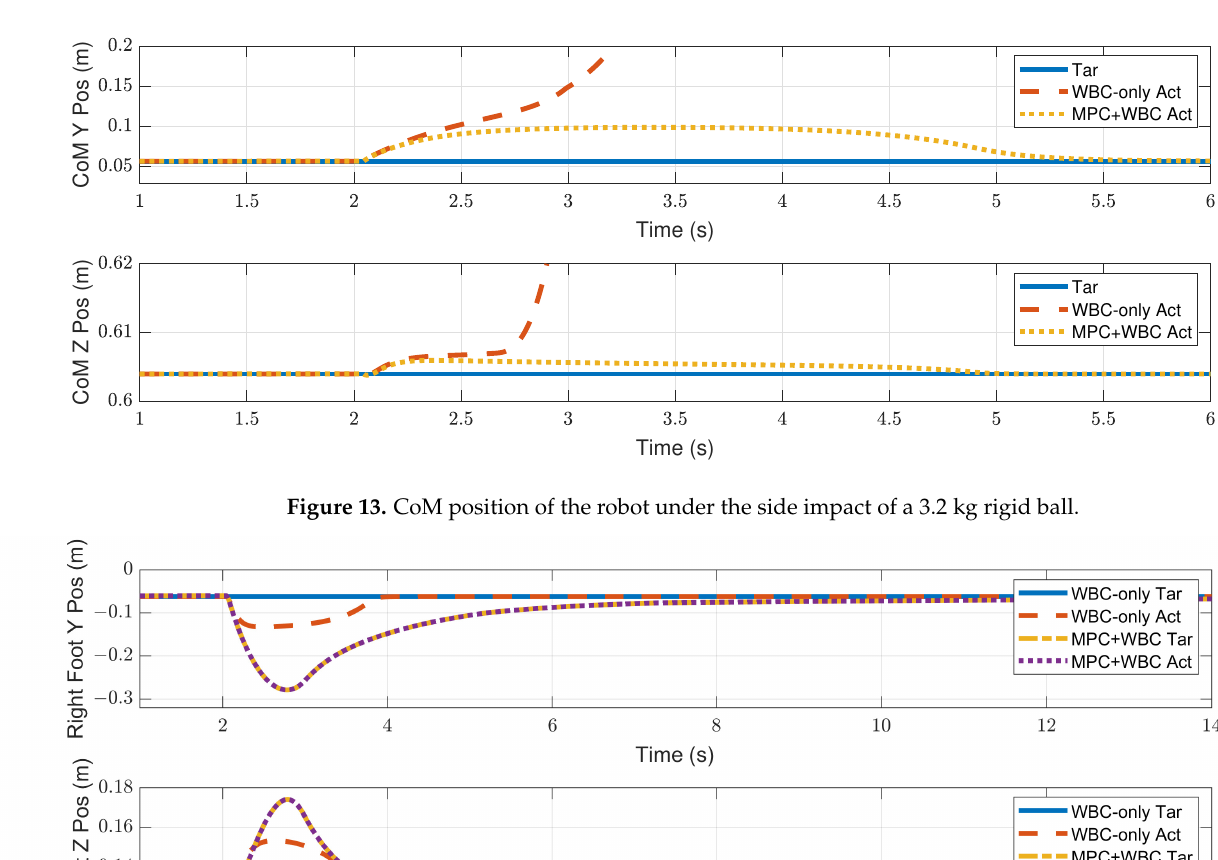
Figure 12. CoM position of the robot under the side impact of a 2.7 kg rigid ball.